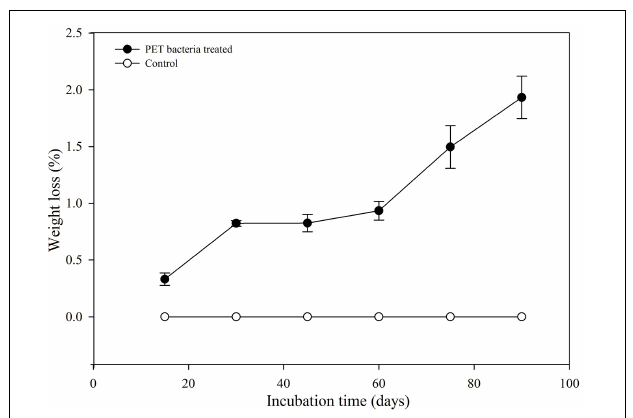
FIGURE 1 | Weight loss of PET film after incubation with Bacillus species AIIW2.